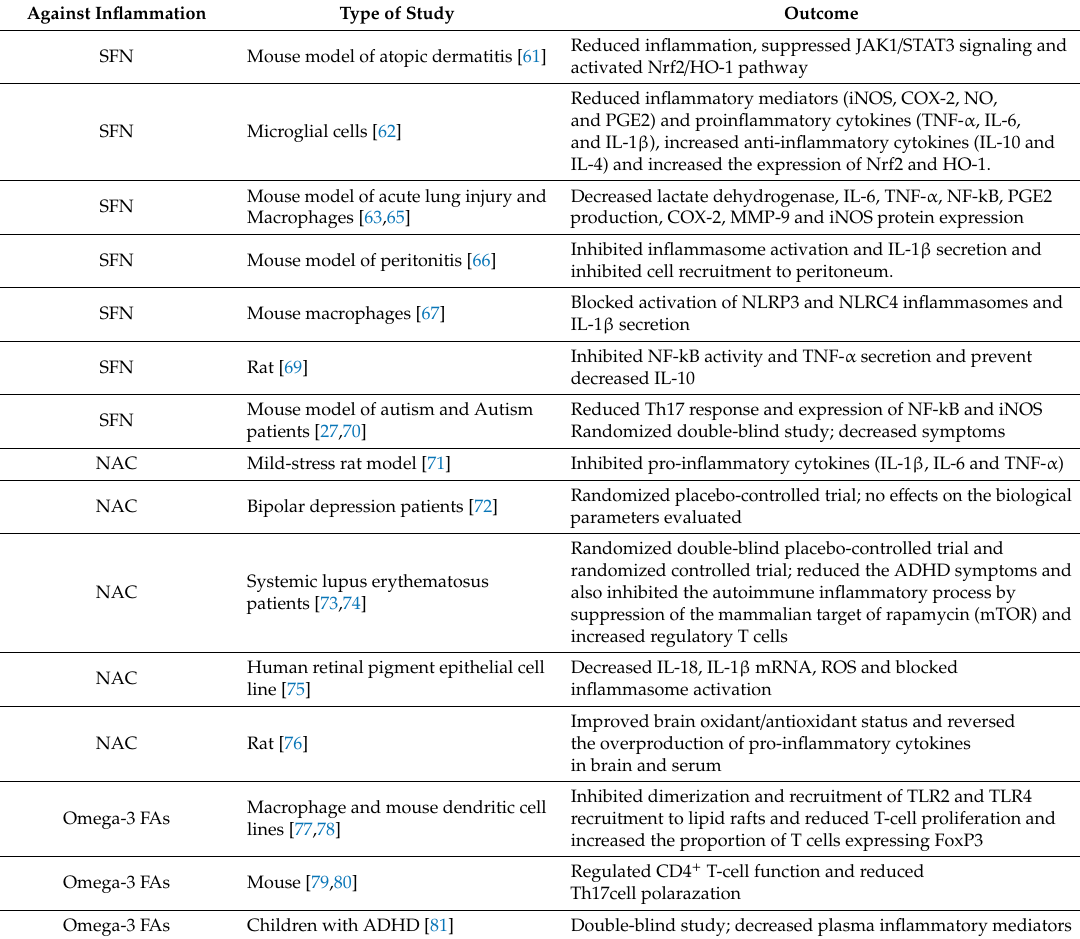
Table 1. Summary of the findings on the potential beneficial e ff ects of antioxidants against inflammation and oxidative